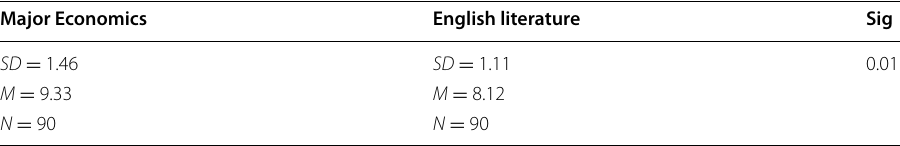
Table 1 Results of independent‑samples t test to compare for differential groups Major